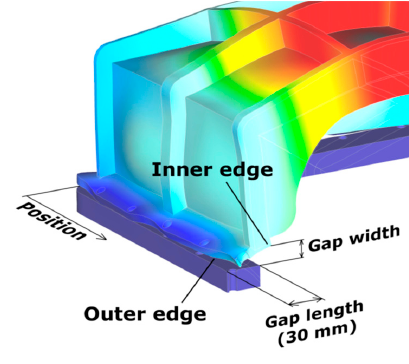
Figure 11. Top cover deformation.